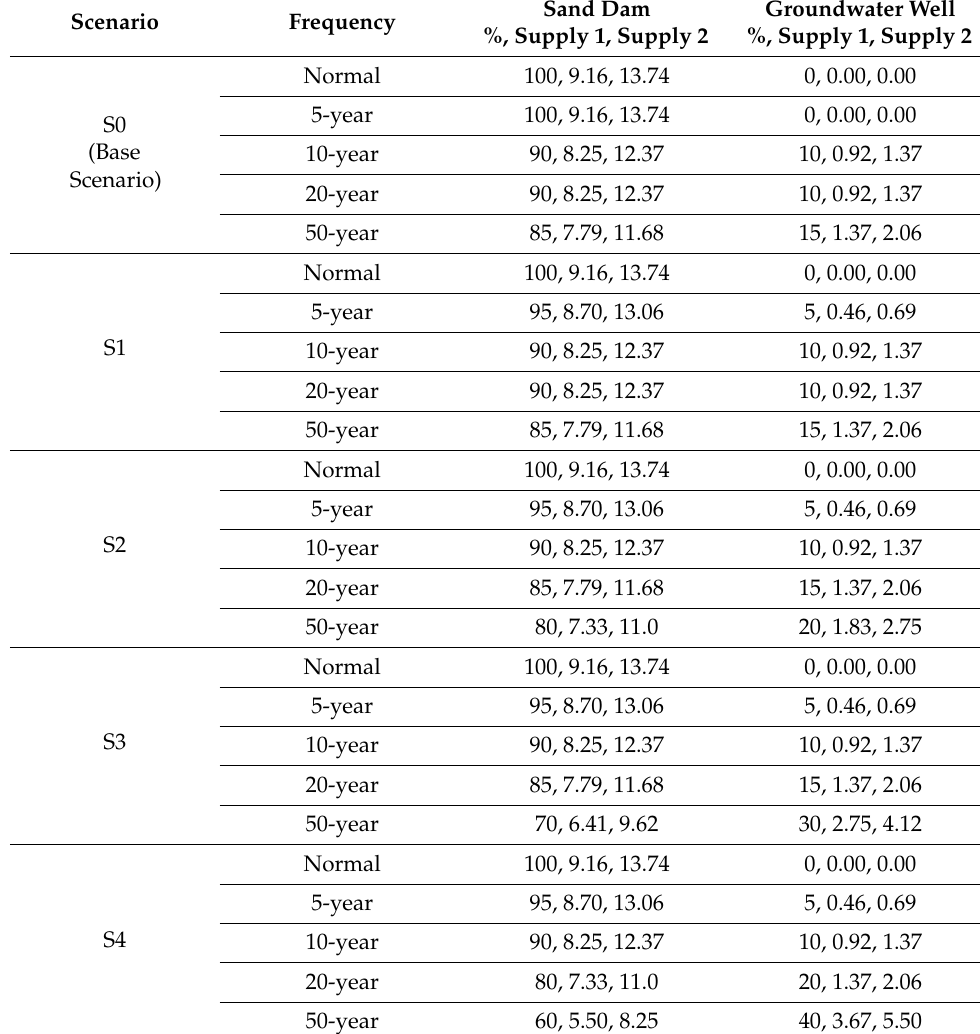
Table 3. Scenarios for water allocation ratio (%) and supply (m 3 /day) under various drought